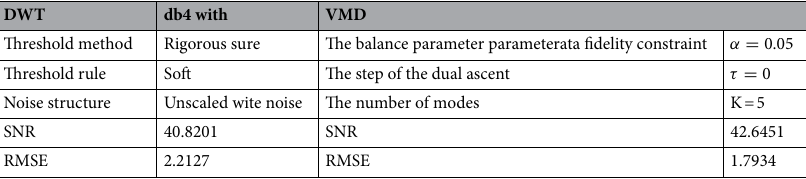
Table 2. The experiment parameters and denoising performance of DWT and VMD.